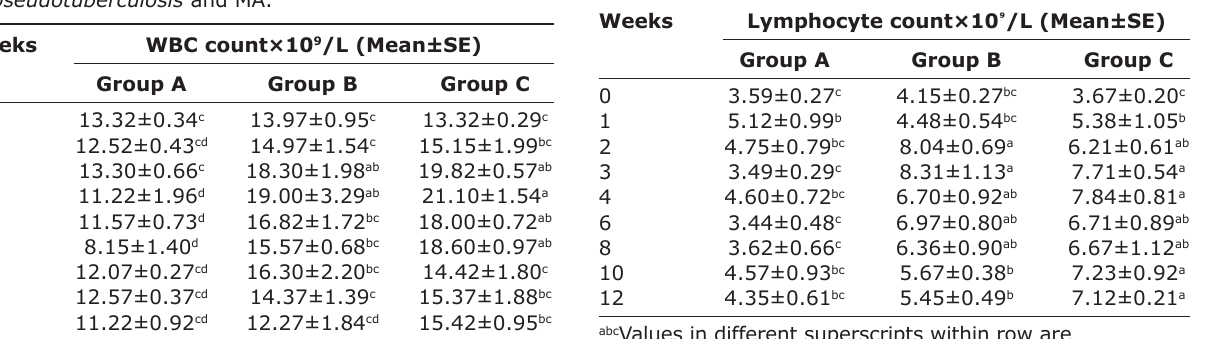
Table-8: Lymphocyte count in female goat’s postinoculation with C. pseudotuberculosis and